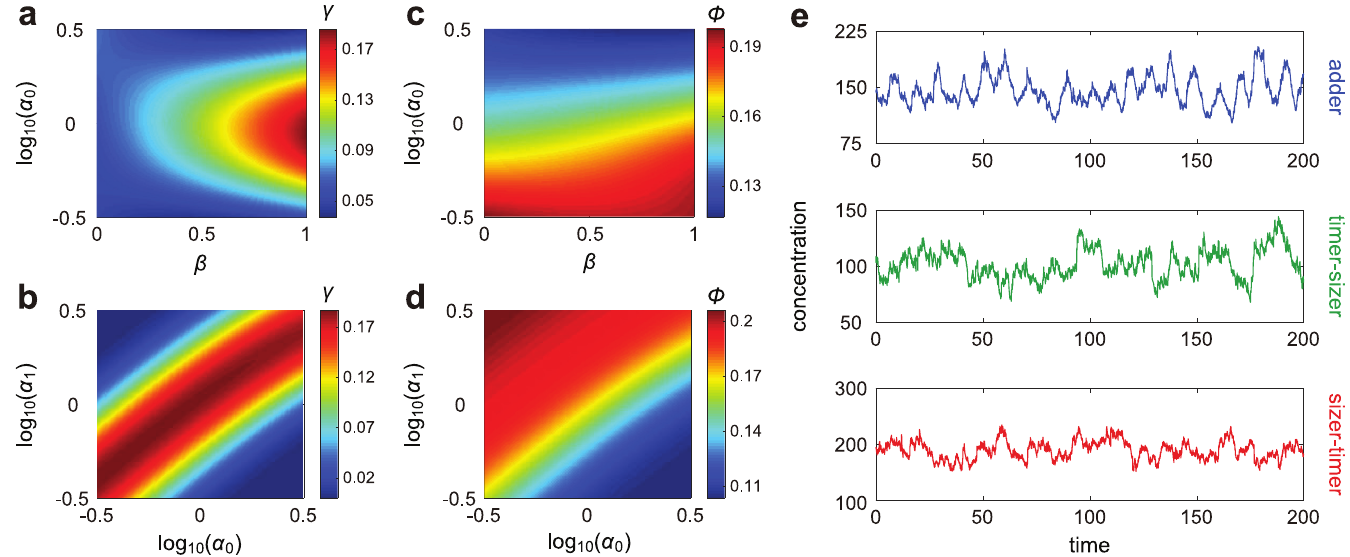
Fig 5. Influence of size control on concentration homeostasis and concentration noise. A,B : Heat plot of γ (the accuracy of concentration homeostasis) versus β (the degree of balanced biosynthesis), α 0 (the strength of size control before replication), and α 1 (the strength of size control after replication). When synthesis is balanced ( β = 1), concentration homeostasis is accurate when the cell applies different size control strategies before and after replication. Both the timer-sizer and sizer-timer compound strategies enhance the accuracy of homeostasis. C,D : Heat plot of ϕ (noise in concentration) versus β , α 0 , and α 1 . While the timer-sizer compound strategy leads to accurate concentration homeostasis, it results in large gene expression noise. The sizer-timer compound strategy both maintains homeostasis and reduces noise. The model parameters are chosen as N = 50, N 0 = 21, ρ = 4.7, B = 1, κ = 2, d = 0.4, η = 4 in A-D, α 1 = 1 in A,C, and β = 1 in B,D. The growth rate g is determined so that f = 0.1. The parameter a is chosen so that the mean cell volume h V i = 1. E : Typical time traces of concentration under three different size control strategies: adder (upper panel), timer-sizer (middle panel), and sizer-timer (lower panel). See Section E in S1 Appendix for the technical details of this figure.